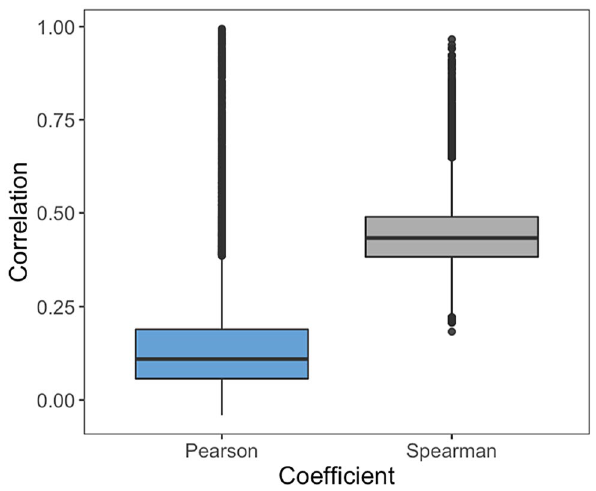
Figure 1. Feature importance correlation. Distributions of feature importance correlation values are reported in boxplots for all protein pairs in the data set. Correlation values were calculated using the Pearson (blue) and Spearman (gray)